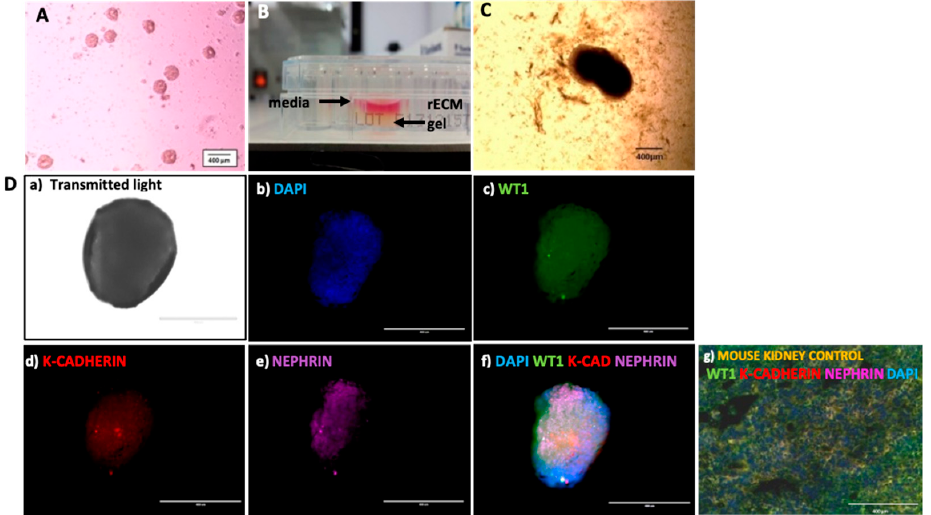
Figure 3. 3D renal cell organoids generated from hiPSC ‐ derived embryoid bodies (EBs) cultured in renal extracellular matrix (rECM) gel express putative markers of renal progenitor cells and mesenchyme to epithelial transition (MET). ( A ) hiPSC ‐ derived EBs prior to renal differentiation protocol. ( B) Image of rECM gel plated in a well of a 48 ‐ well tissue culture plate, overlaid with cell culture medium. ( C ) hiPSC ‐ derived EBs were subjected to a renal differentiation protocol to drive them to develop into metanephric mesenchyme (MM ‐ EBs). MM ‐ EBs were then embedded in a murine renal